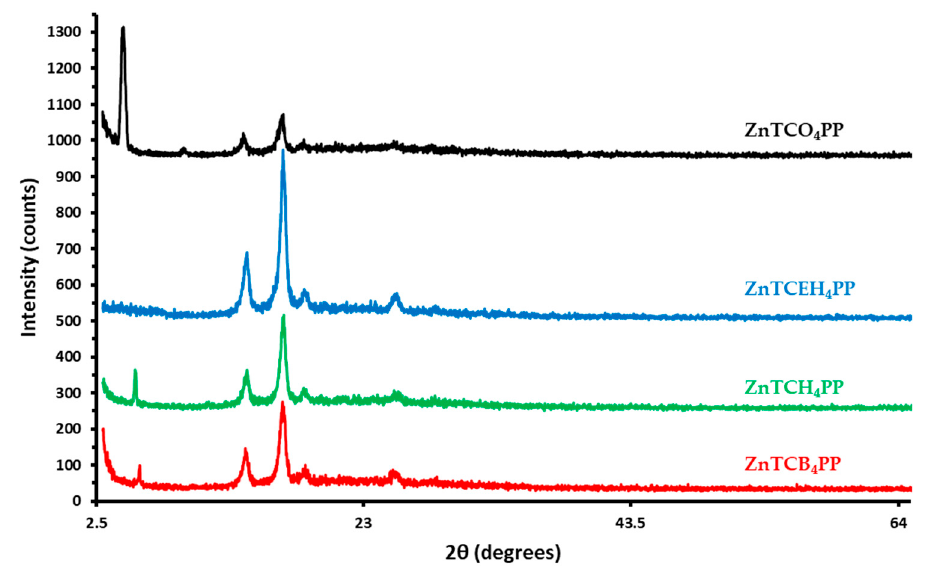
Figure 4. X-ray diffraction patterns of solution-cast thin films of ZnTCB 4 PP ( - ), ZnTCH 4 PP ( - ), ZnTCEH 4 PP ( - ), and ZnTCO 4 PP ( - ).